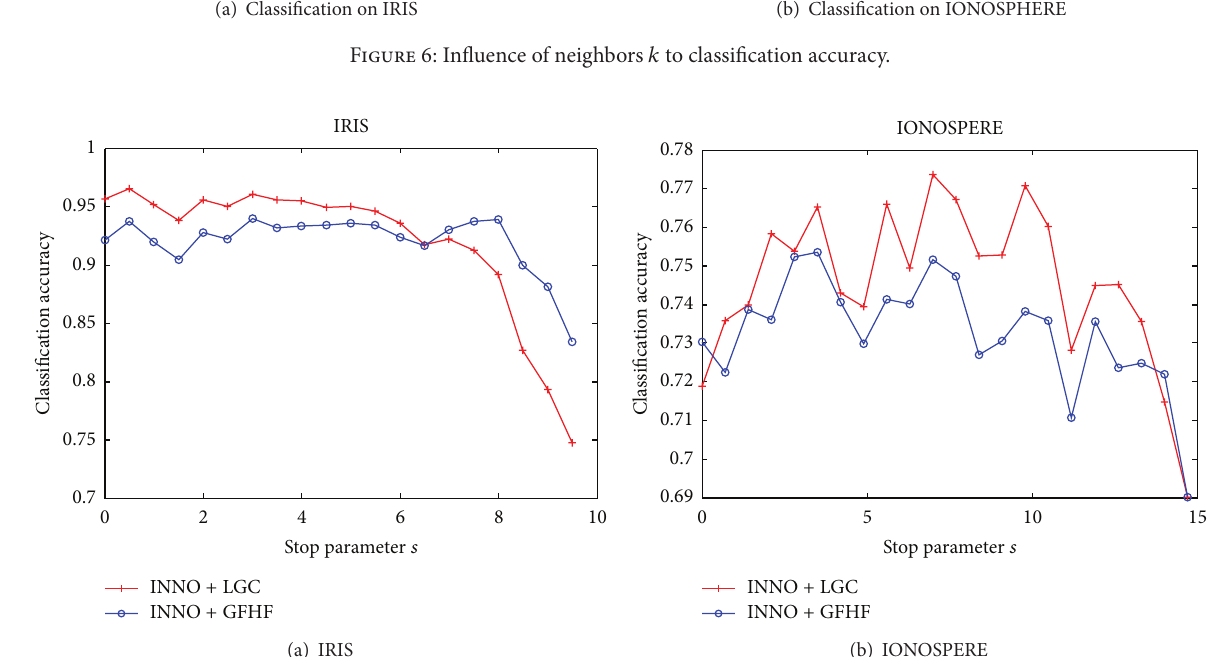
Figure 7: Influence of stop parameter 𝑠 to classification